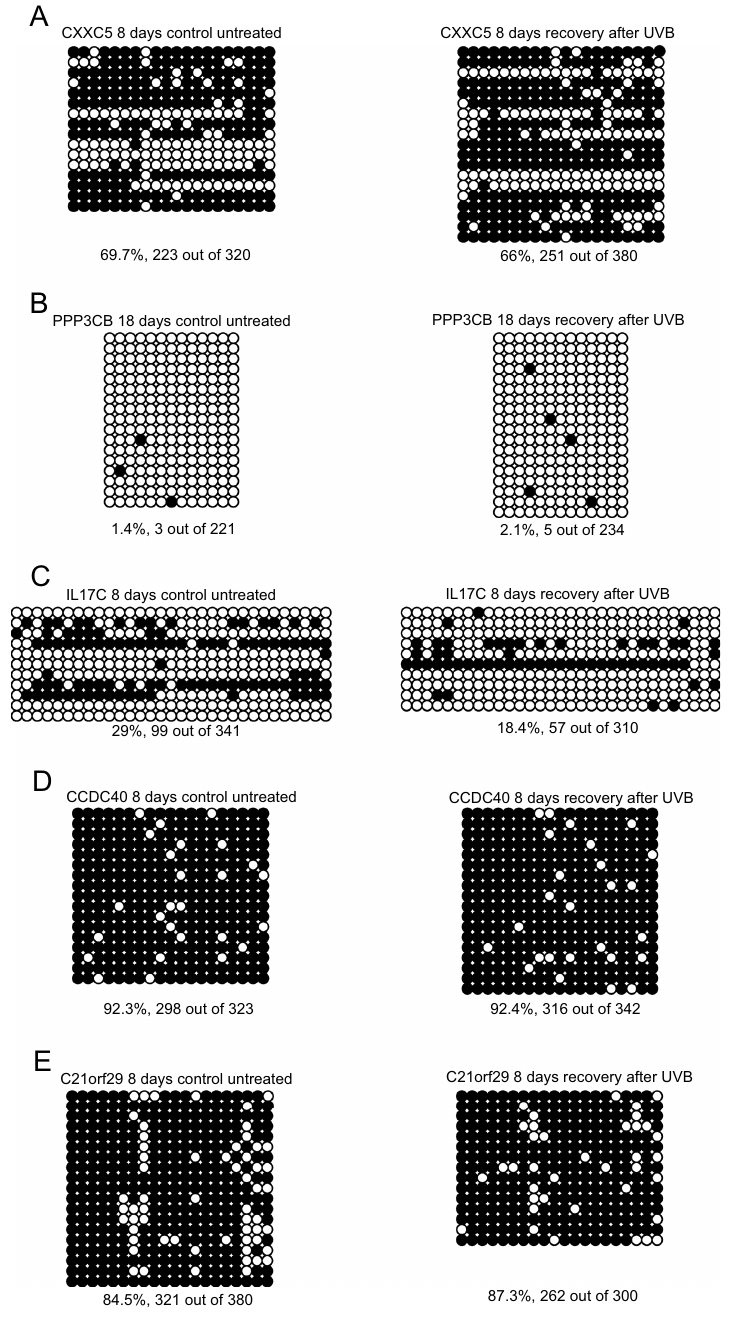
Figure 4. DNA methylation analysis by bisulfite sequencing of candidate differentially methylated genes. Bisulfite sequencing data are shown for the genes CXXC5 ( A ), PPP3CB ( B ), IL17C ( C ), CCDC40 ( D ), and C21orf29 ( E ). The chronic UVB dose was 260 J/m 2 . Open circles represent unmethylated CpG sites and black circles indicate methylated CpG sites. The percentage of methylated sites is indicated below the sequence data for individual cloned